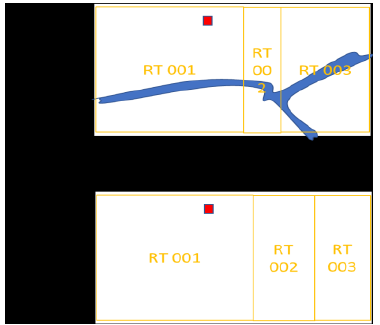
Fig. 5. Illustration of alignment with landmark and road (C) and with landmark only (D)